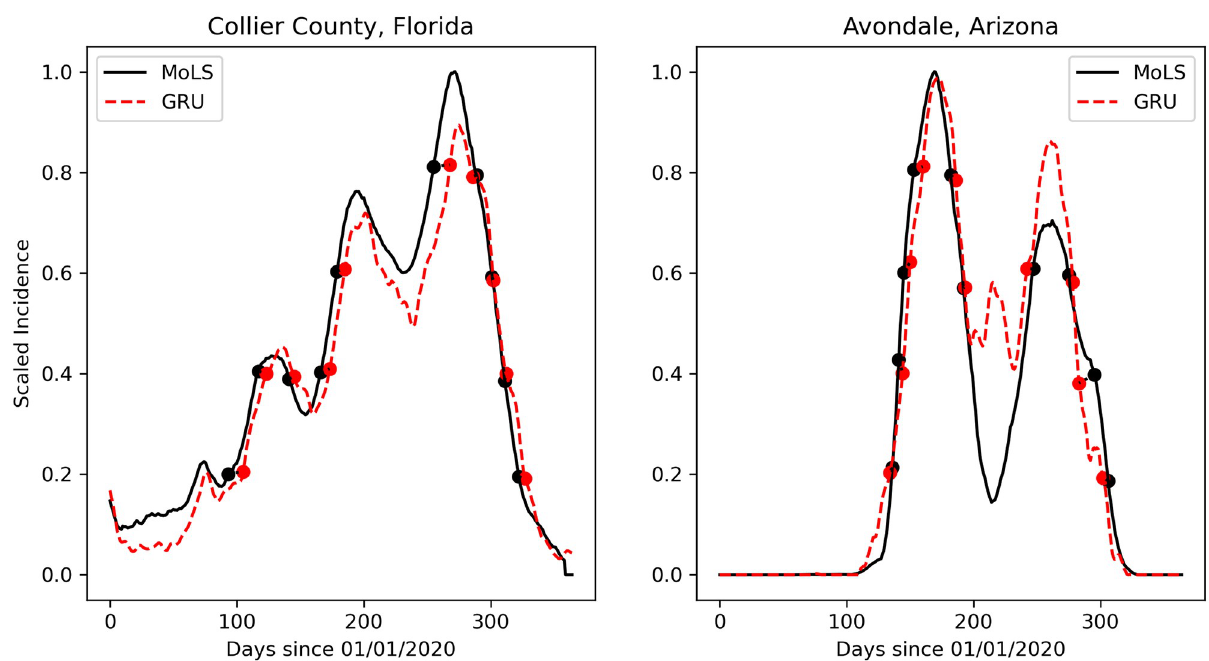
Fig 5. Observed (black solid curve) and predicted (red dashed curve for the GRU model) scaled abundance in Collier County, FL ( left ) and Avondale, AZ ( right ). To make it easier to visualize thresholds, each trace is scaled to the peak height of the observed (MoLS) abundance. The dots mark the times when each time series reached 20%, 40%, 60%, and 80% of the maximum MoLS abundance. Points in matching pairs are connected by dotted lines, whose projection on the horizontal axis has length D or D . Black (resp. red) dots that are not matched to a red (resp. black) dot are on off omitted in this figure for